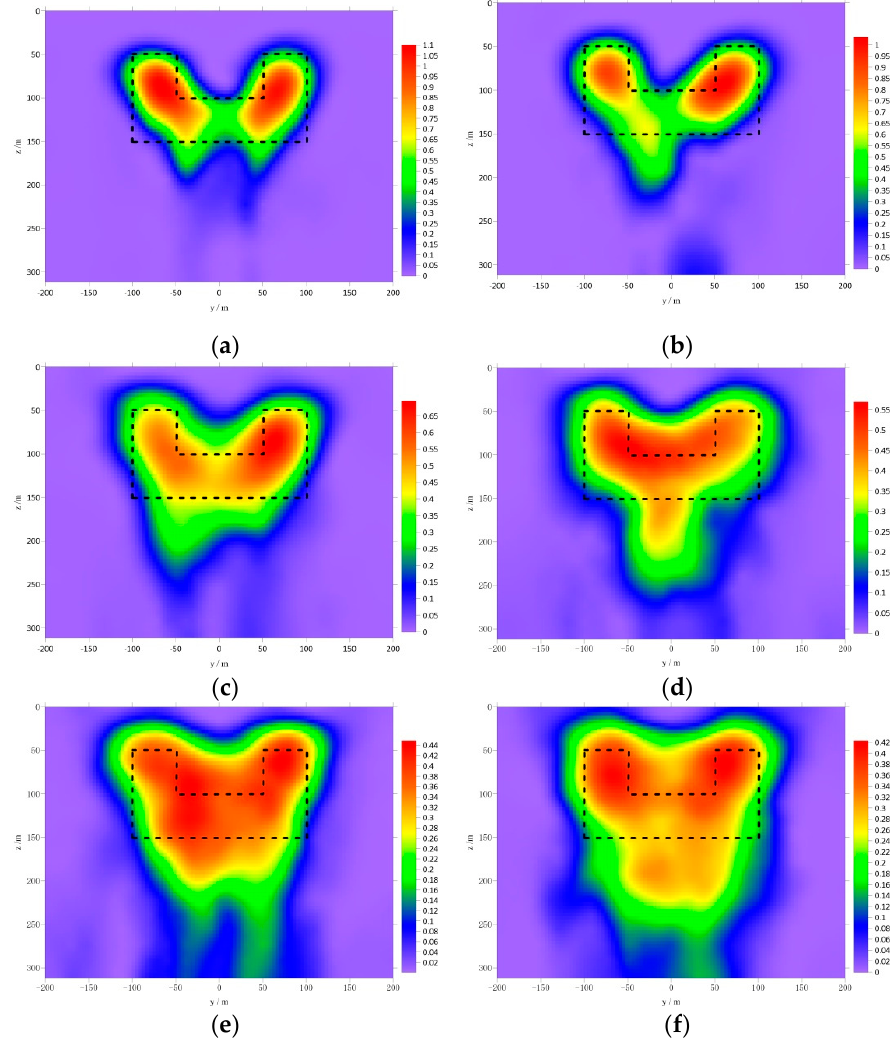
Figure 6. The inversion results of the model shown in Figure 2d with different 𝑝 values. ( a ) 𝑝 = 1 , ( b ) 𝑝 = 1.1 , ( c ) 𝑝 = 1.3 , ( d ) 𝑝 = 1.5 , ( e ) 𝑝 = 1.7 , ( f ) 𝑝 = 2 .